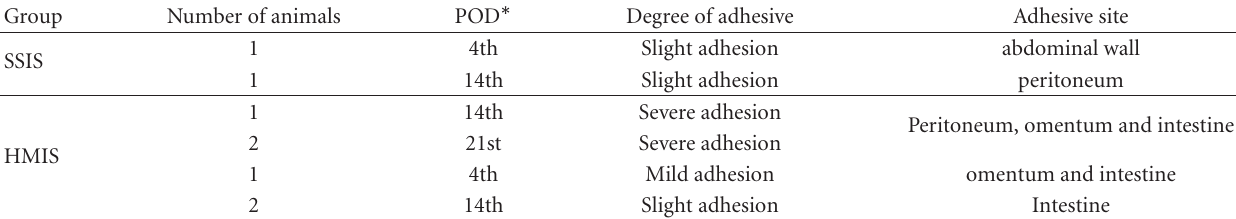
Table 3: The number of animals which got adhesion, adhesive degrees, and sites in the SSIS and HMIS groups. Group Number of animals POD ∗ Degree of adhesive Adhesive site 1 4th Slight adhesion abdominal wall SSIS 14th Slight adhesion peritoneum 14th Severe adhesion Peritoneum, omentum and intestine